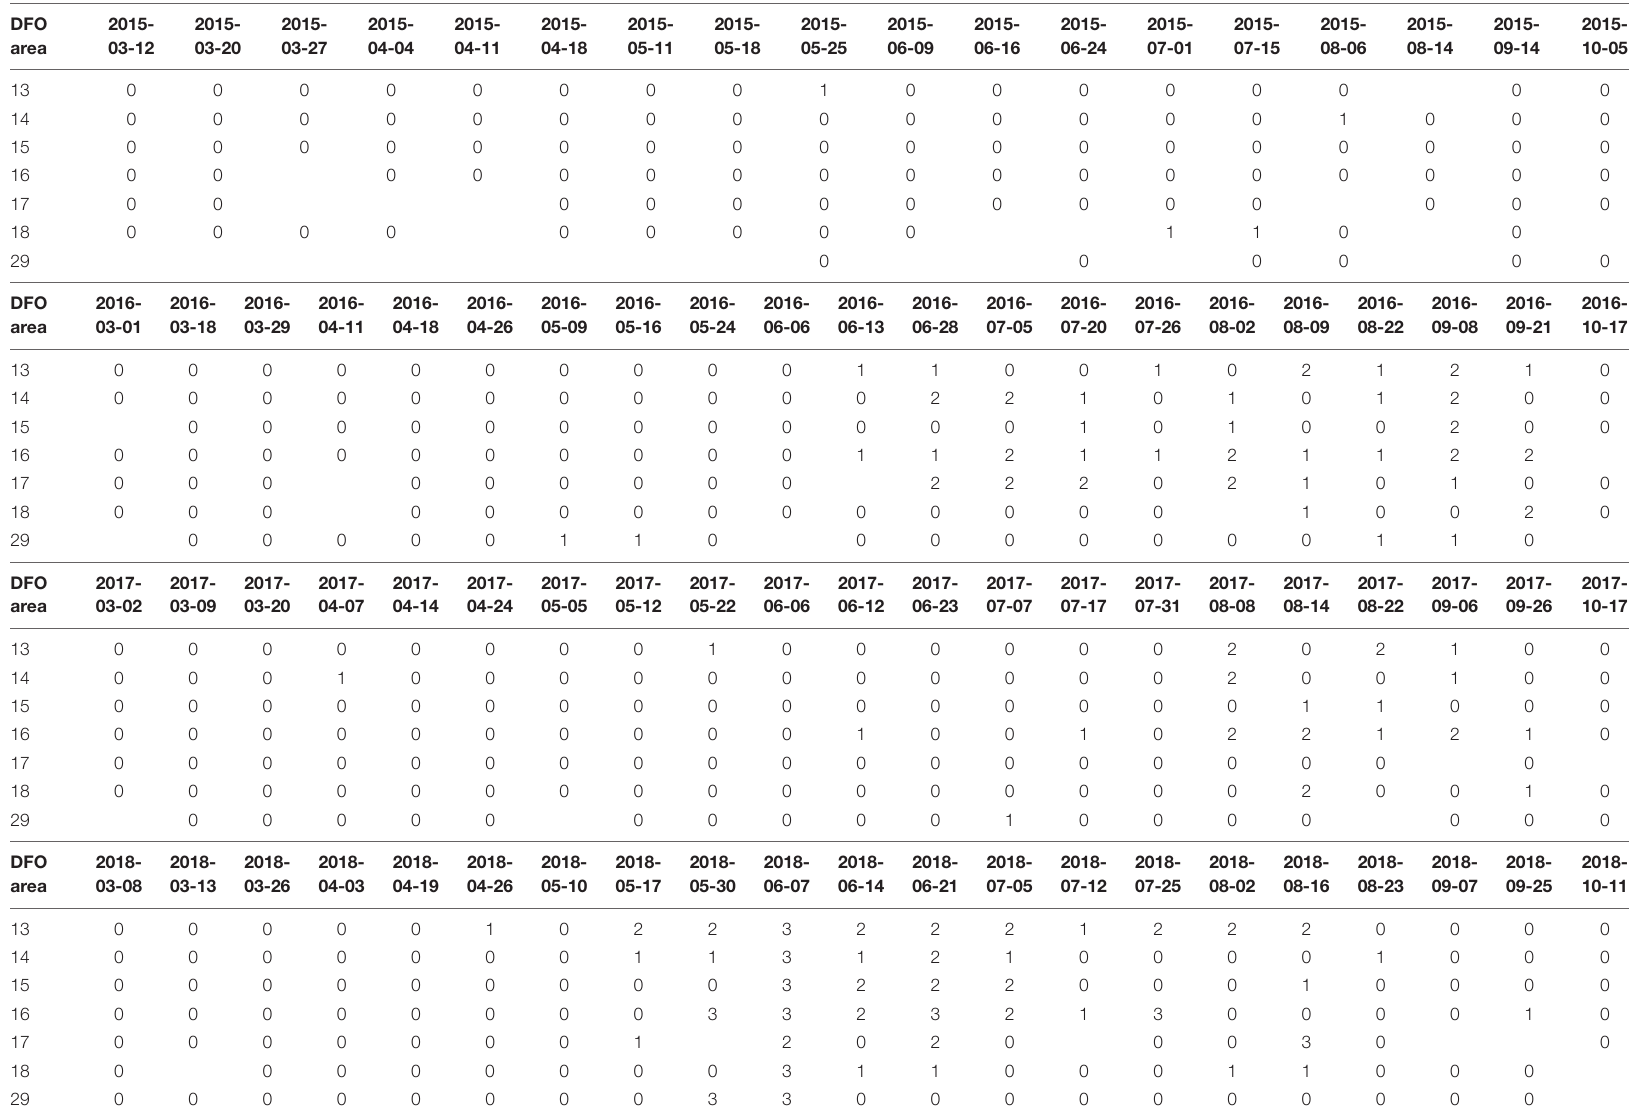
TABLE 6 | Heterosigma akashiwo levels (level 1 ≤ 10 cell mL − 1 ; level 2 = 10–499 cell mL − 1 , level 3 ≥ 500 cell mL − 1 ) based on maximum cell concentration encountered in DFO management areas for each year 2015–2018. DFO